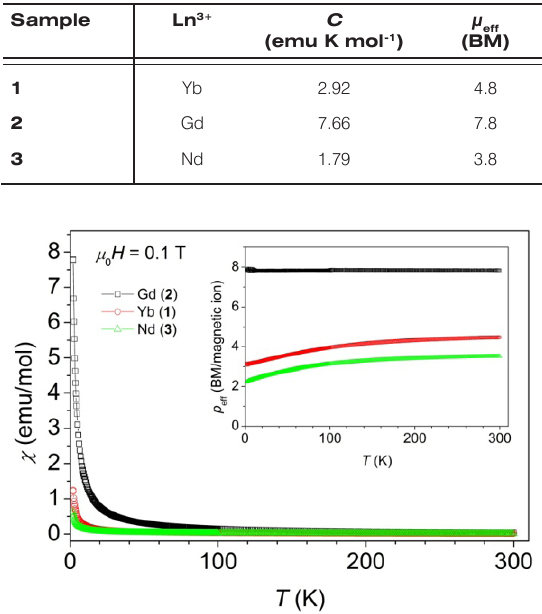
Table 5. Curie constants and effective magnetic moments of Ln(III).